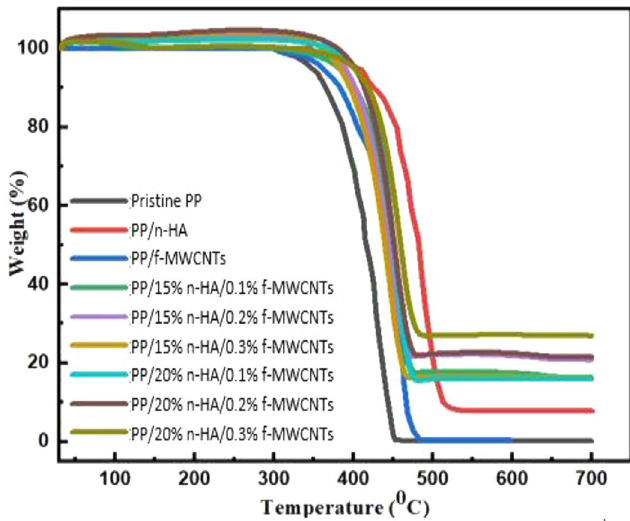
Figure 3. Thermogravimetric analyzes curve for nanocomposites.